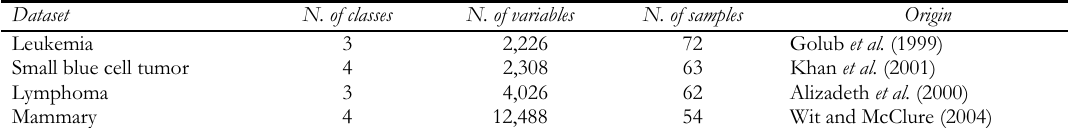
Dataset description